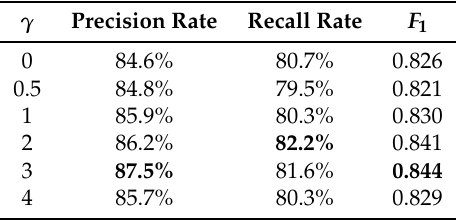
Table 6. Detection performance of the model with different γ .